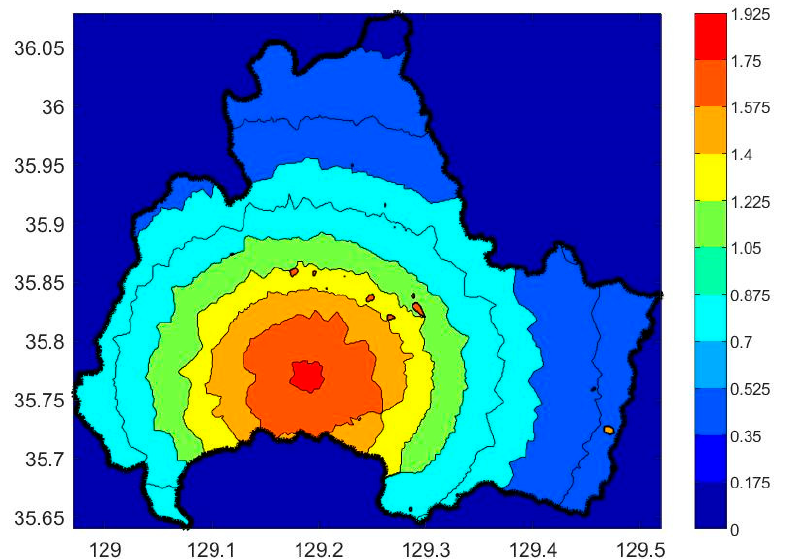
Figure 12. Map for the maximum displacement estimation based on the maximum PGA of 0.404g with Gyeongju earthquake in Gyeongju.